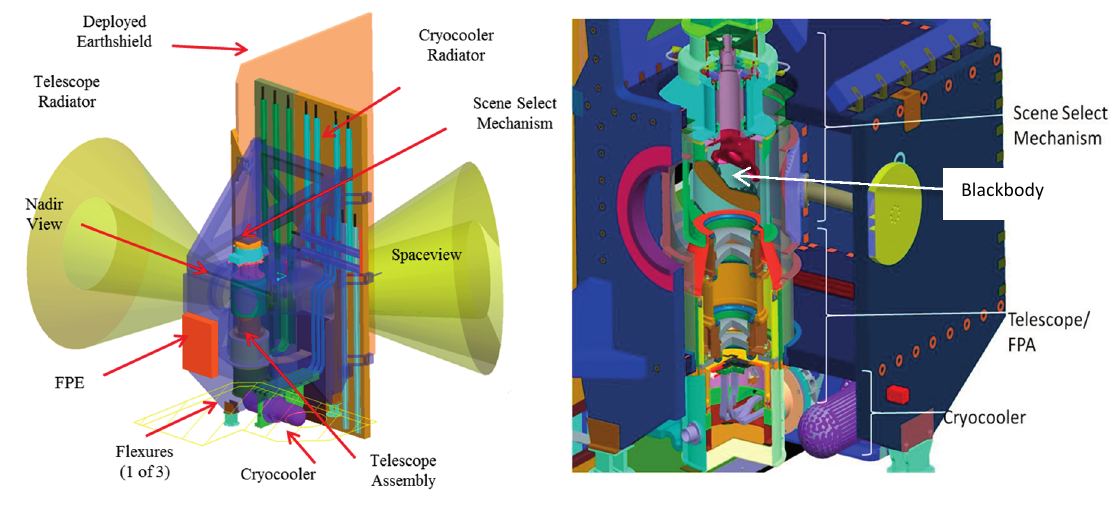
Figure 4. ( Left ) TIRS sensor unit with Earth shield deployed and showing FOVs. ( Right ) Drawing of the optical system, including the SSM, the four lens elements and the focal plane assembly. At the bottom, the cryocooler and the heat straps used to cool the FPA are shown. The blackbody calibration source is shown with its attached